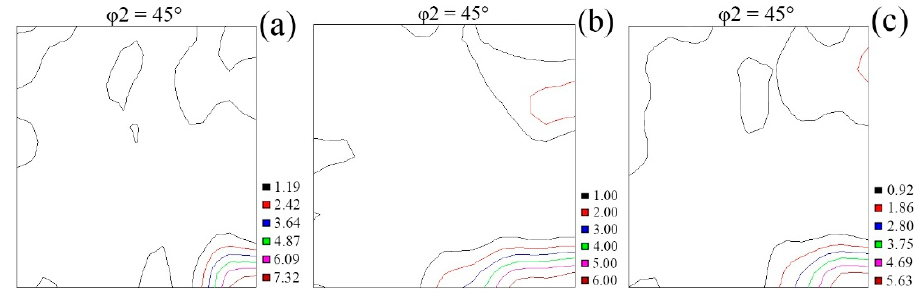
Figure 5. Macro-texture ( ϕ 2 = 45 ◦ section of ODF) of samples rolled with different reduction rates ( a ) 800 ◦ C—88%, ( b ) 800 ◦ C—78%, ( c ) 800 ◦ C—67%.